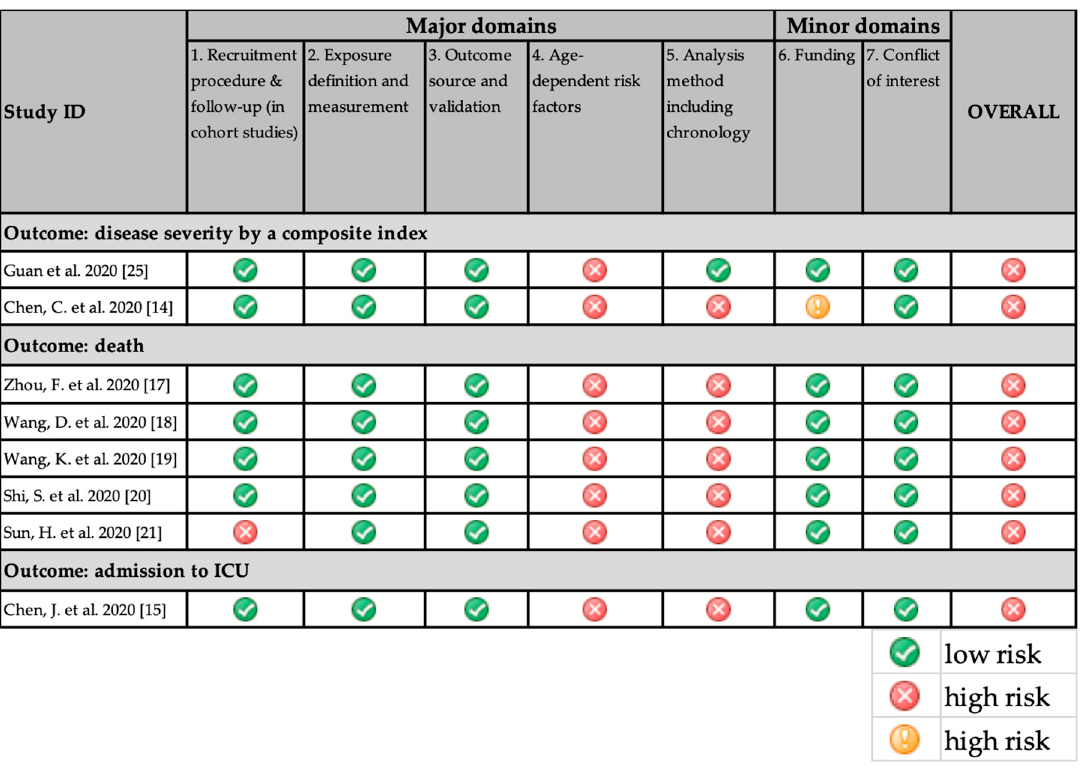
Figure 2. Risk of bias of studies by outcome.